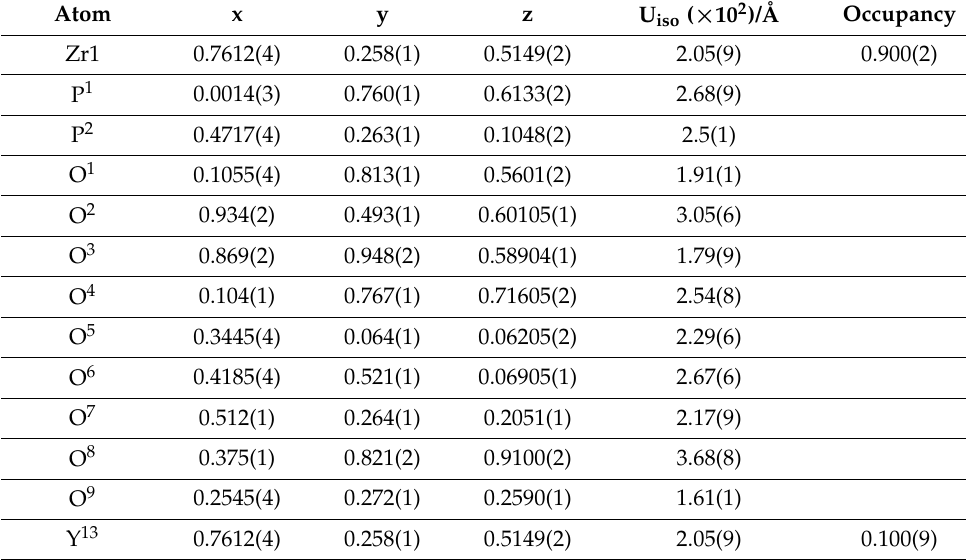
Table 4. Refined fractional atomic coordinates and isotropic thermal displacement parameters for conventionally refluxed 10%